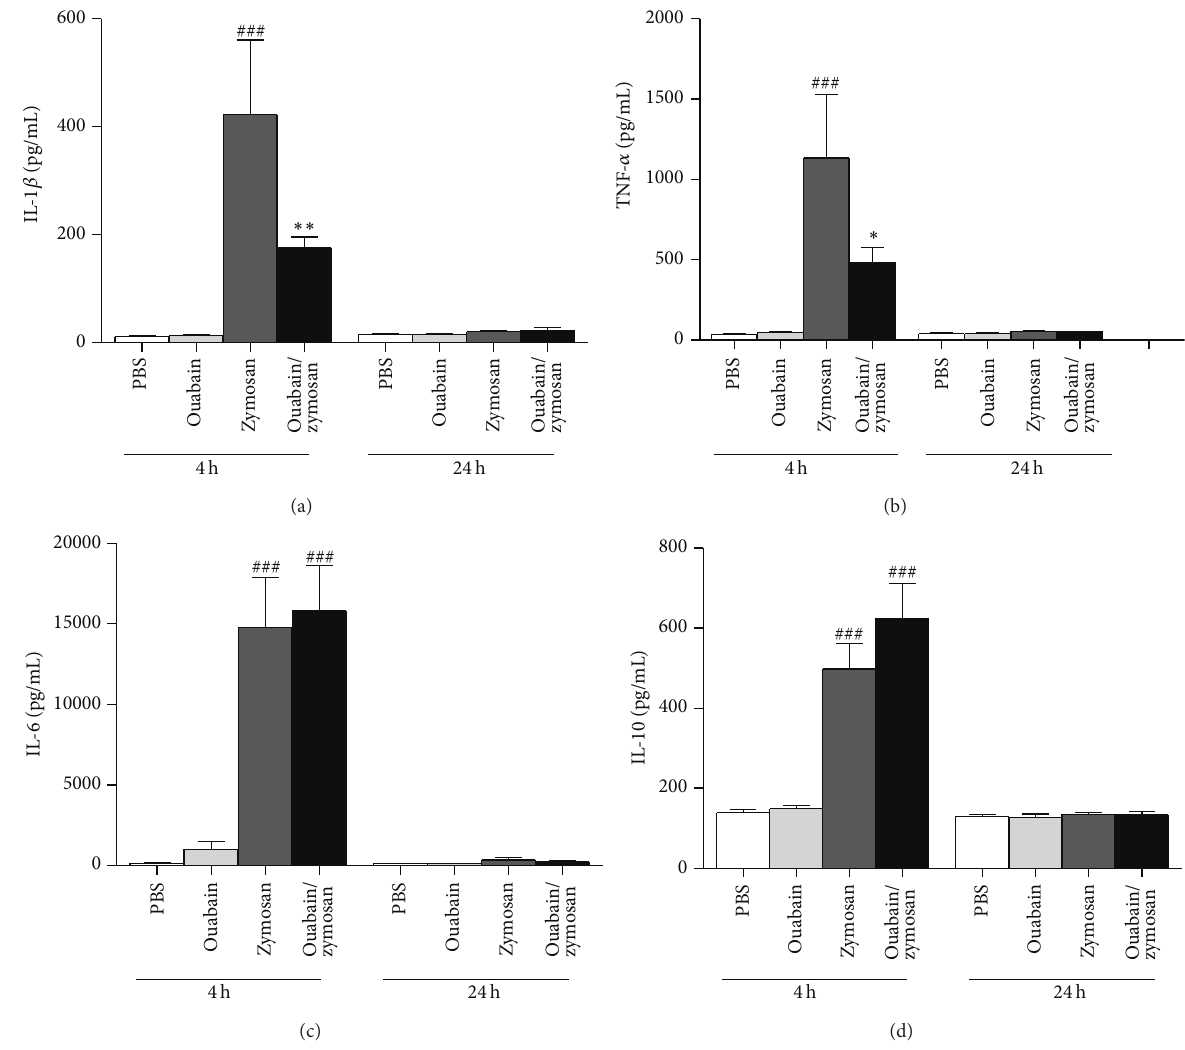
Figure 4: Effect of ouabain on proinflammatory and anti-inflammatory cytokines levels. Swiss mice ( 𝑛 = 8 ) were treated for three consecutivedayswith0.56 mg/kgofouabainorvehicle(PBS).After4and24 hstimulationwithzymosan,theperitonealexudatewascollected, centrifuged, and stored at − 20 ∘ C until cytokine assay. Levels of IL-1 𝛽 (a), TNF- 𝛼 (b), IL-6 (c), and IL-10 (d) were measured in the exudate supernatant by ELISA. Results were expressed as mean ± SEM and analyzed by Graphpad Prism using ANOVA with Tukey’s posttest, where all groups were compared. ### 𝑃 < 0.001 versus PBS group; ∗ 𝑃 < 0.05 and ∗∗ 𝑃 < 0.01 versus zymosan